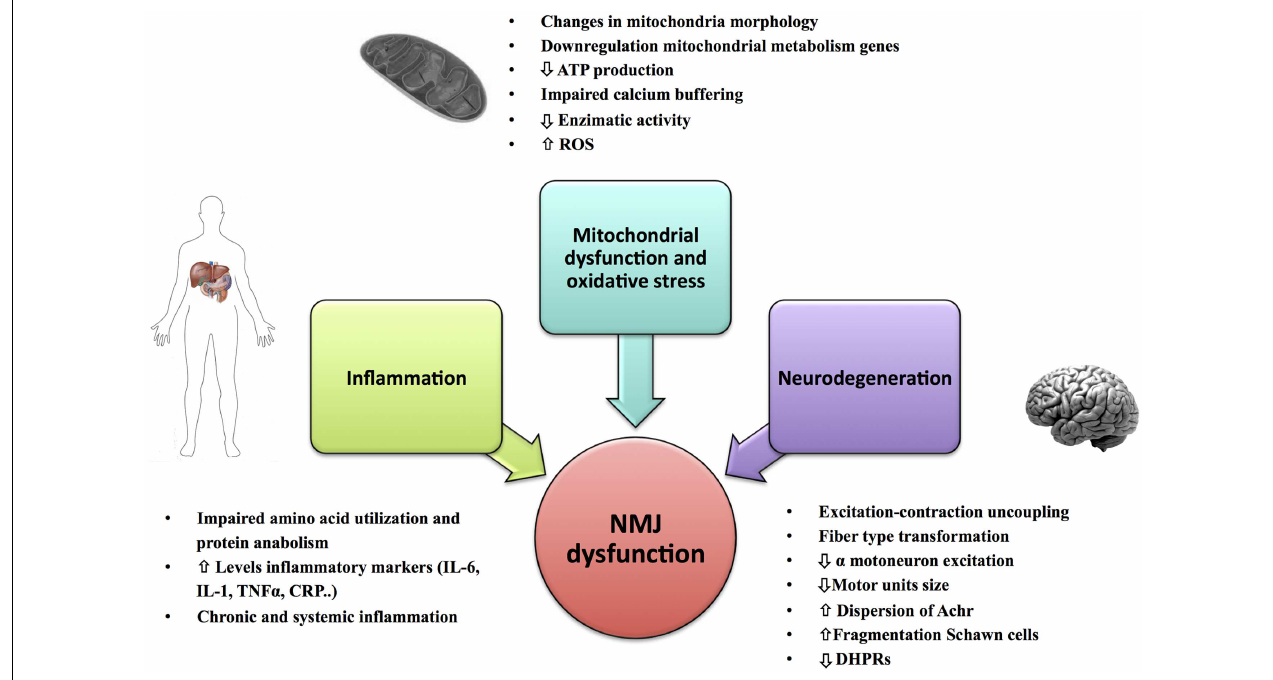
FIGURE 2 | Primary causes of NMJ dysfunction during aging . Factors such as mitochondrial dysfunction, oxidative stress, inflammation, and changes in the innervation of muscle fiber and mechanical properties of the motor units could play an important role in the NMJ degeneration and development of